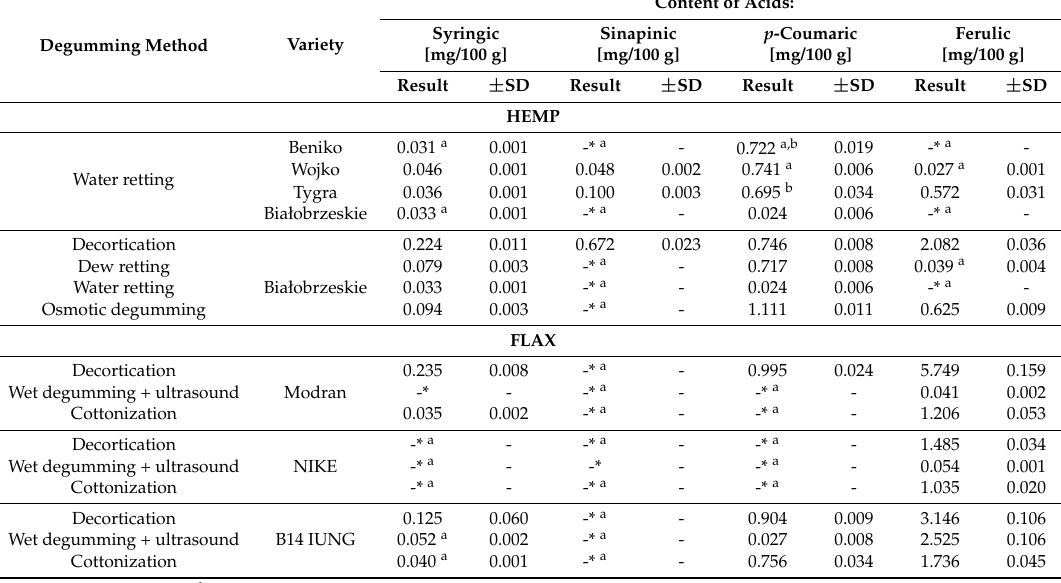
Table 2. Acid content in the flax and hemp fiber. Results are expressed as mean ± standard deviation (SD), n = 4. Lower-case letters indicate significant differences at p ≤ 0.05 according to the Tukay’s HSD